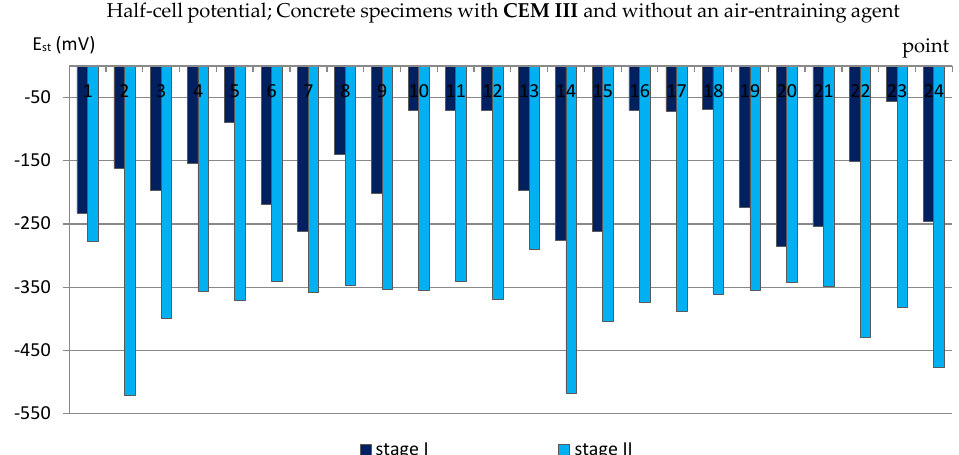
Figure 10. Half-cell potential of reinforcement measured in C_III_n specimens.